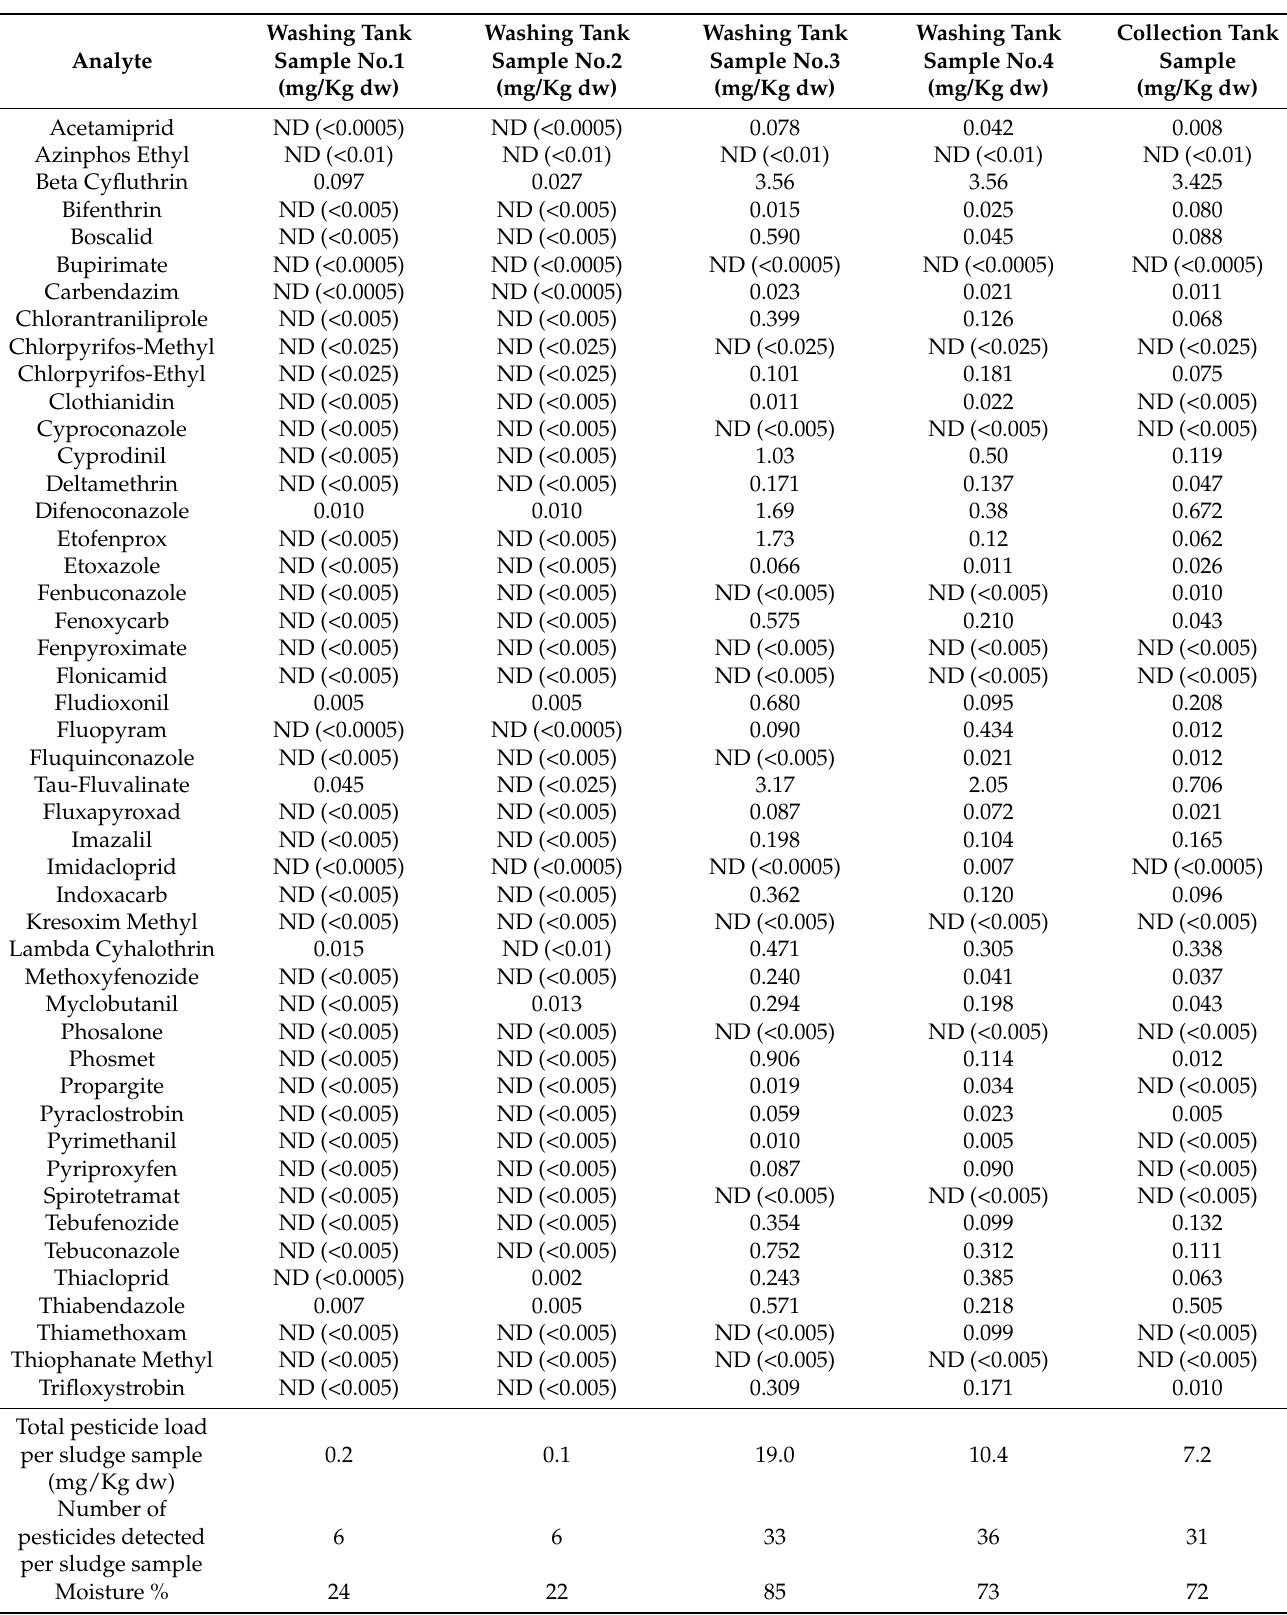
Table 3. Concentrations of pesticides determined in agro-food industry sludge